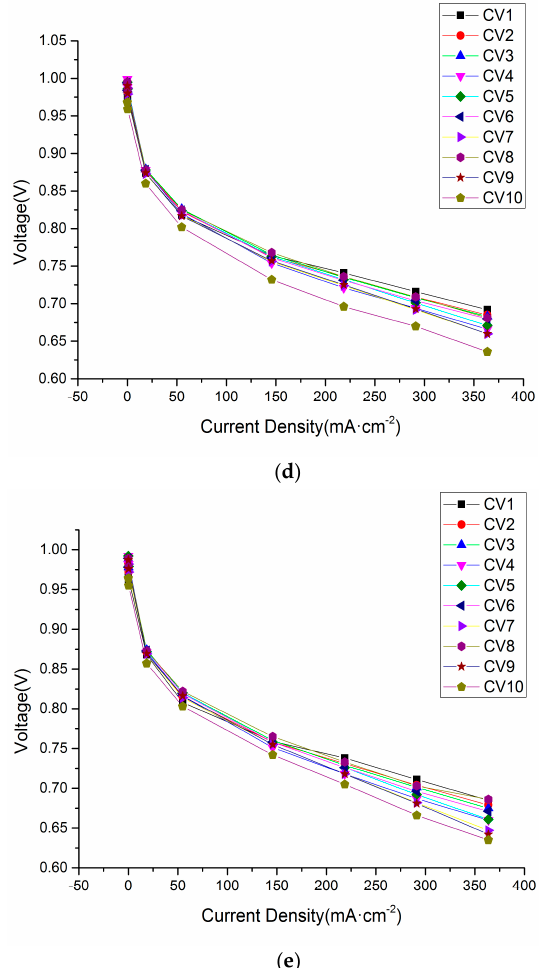
Figure 5. Polarization curves with 10 single cells with different relative humidity. The inlet pressure is 0.1 MPa. Working and ambient temperatures are 70 °C and 25 °C, respectively. ( a ) RH: 40%; ( b ) RH: 55%; ( c ) RH: 70%; ( d ) RH: 85%; ( e ) RH: 100%. Table 2. Dynamic performance at different relative humidities (40%).